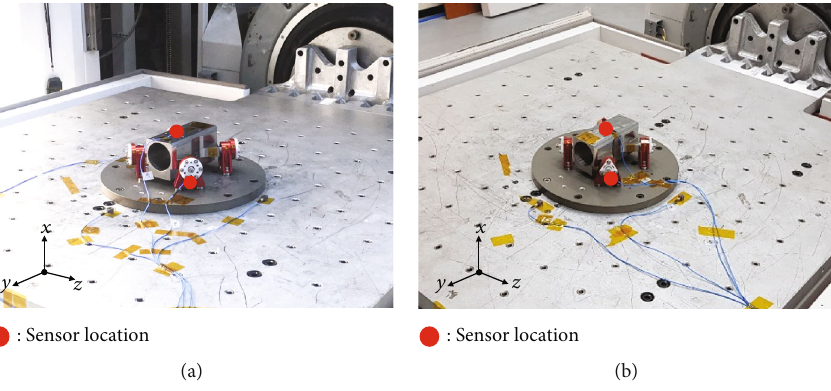
Figure 6: Launch vibration test set-up ((a) PLOVIS-II, (b) PLOVIS-I). Table 2: Speci fi cation of sine vibration test.